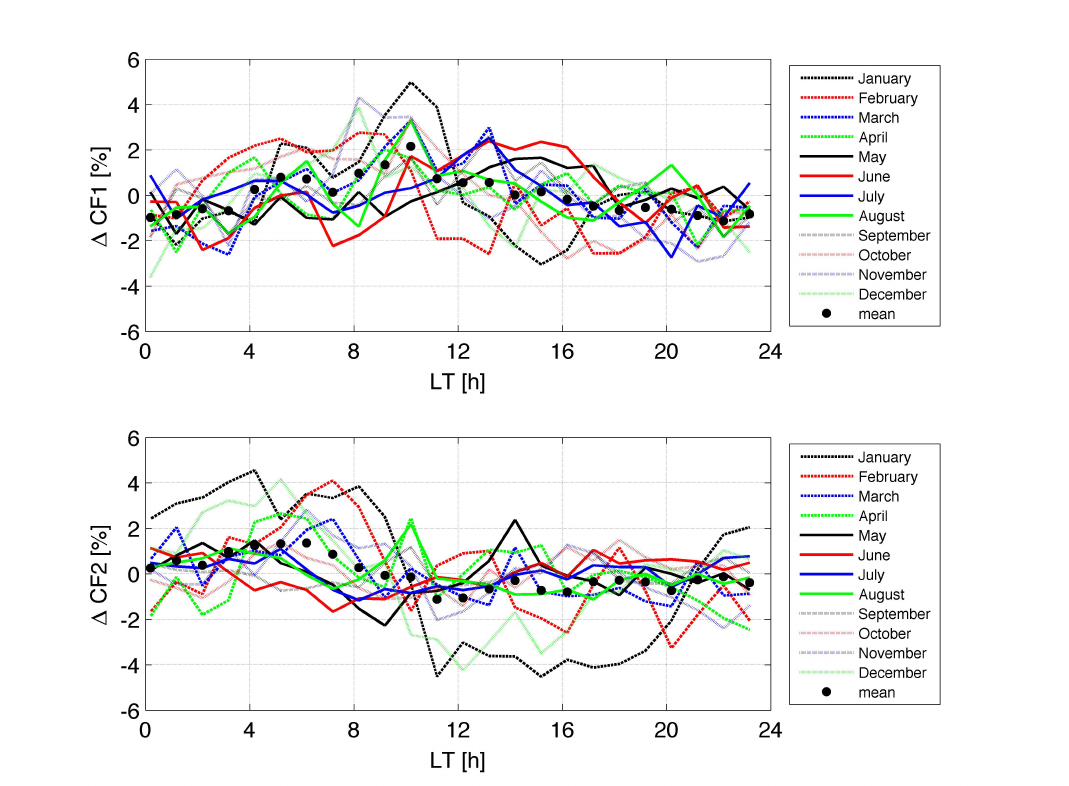
Figure 7. Seasonal dependence of the diurnal cycle in cloud fraction ∆ CF1 (thin liquid water clouds) and ∆ CF2 (supercooled thick liquid water clouds) as a function of local time over Bern for the time interval 2004–2016. The panels show ∆ CF = (CF − monthly mean of CF). The black dots indicate the annual mean of the seasonal